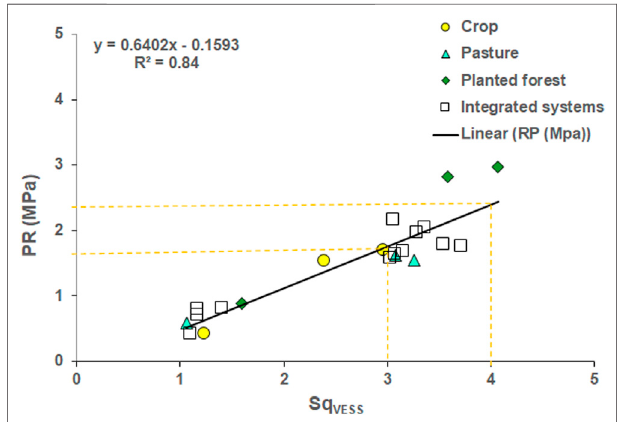
FIGURE 3 | Relationship between soil penetration resistance (PR) and soil structural quality score (Sq VESS ) based on visual evaluation of soil structure.